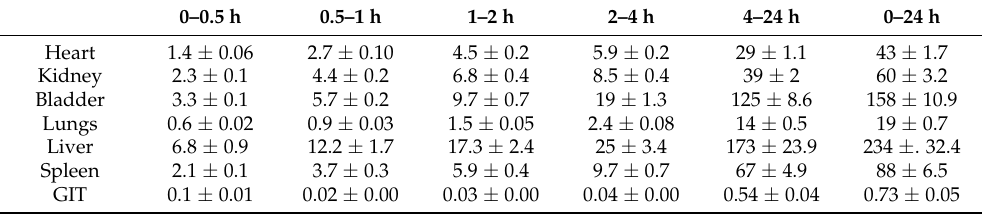
Table 2. Cumulated activity in rabbit organs over time (0–24 h), following intravenous bolus admin- istration of 99mTc Q9P35GC micelles (80 ± 2 MBq). Values in MBq h, presented as mean ± SEM ( n = 5).